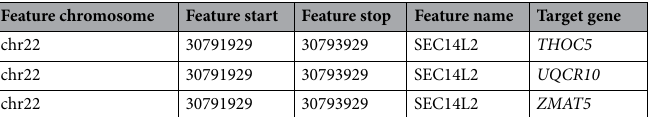
Table 1. Putative casual regulatory elements and target genes. The results of the integrative approach to identifying pathogenic targets. The chromosomal coordinates of the causal features are listed, along with their putative target genes. Targets shown in italic are considered differentially expressed between any of the